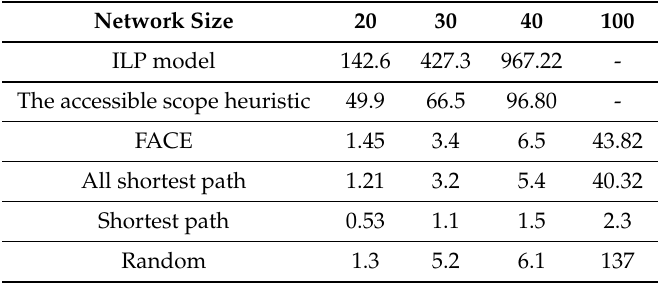
Table 2. Execution times in seconds for networks of different